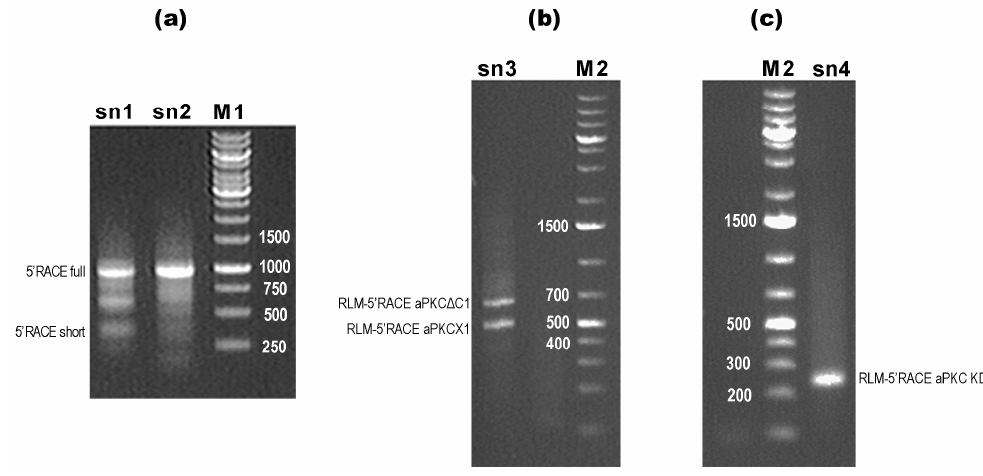
Figure A2. Agarose gel electrophoreses of products generated by the last round of 5’RACE (rapid amplification of cDNA 5’-end) in two experiments. ( a ) The third round of classic 5’RACE. RNA samples from two snails (sn1 and sn2) were initially used, but RACE products were later purified and cloned only for snail 1. ( b ) The second round of RLM-5’RACE (RNA ligase-mediated rapid amplification of cDNA 5’-end), snail 3 (sn3). ( c ) The second round of RLM-5’RACE, snail 4 (sn4). M1, M2—molecular weight markers (Thermo Scientific #SM0311 and Thermo Scientific #SM1331, respectively); white numbers represent marker bars lengths